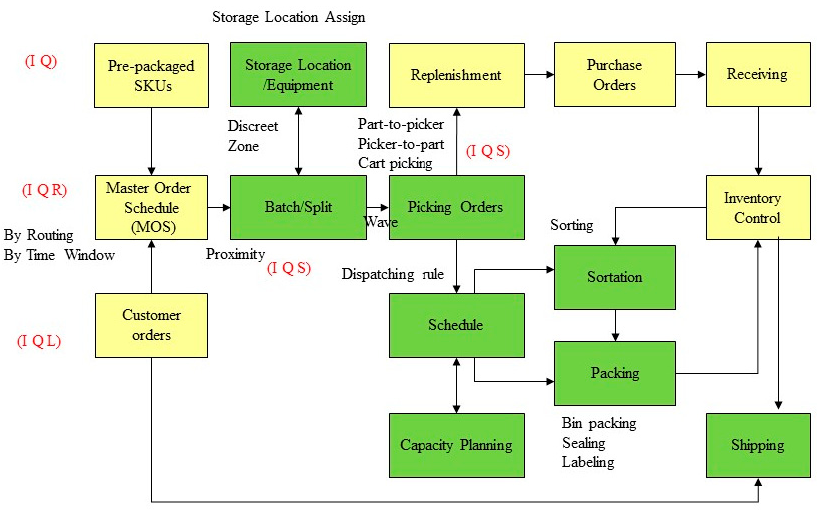
Figure 3. Wave planning model that integrates those green blocks.